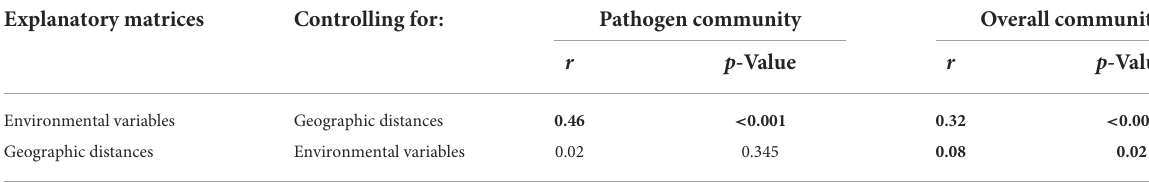
TABLE 1 The effects of environmental variables and geographic distances on the pathogen community and the overall community based on the partial Mantel test. Explanatory matrices